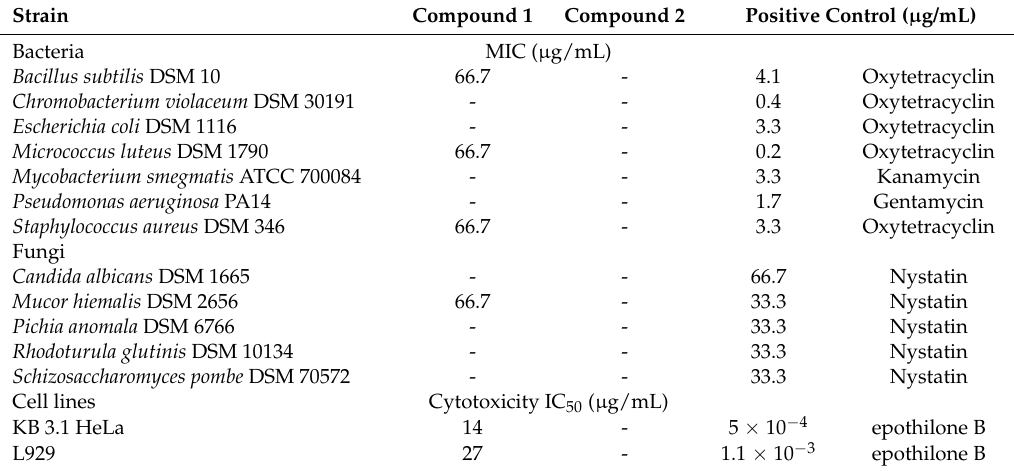
Table 2. Antimicrobial and cytotoxic activities of compounds 1 and 2 .